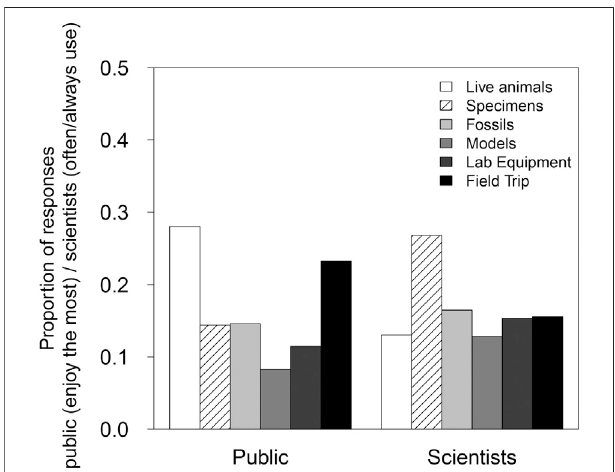
FIGURE 3 | Comparison between the public ’ s preferred hands-on activitiesandscientists ’ useofsuchactivities(Q2.20andQ1.17,respectively). The barplots indicate the proportion of times the public selected each activity and the proportion of times the scientists mentioned each activity as either often or always